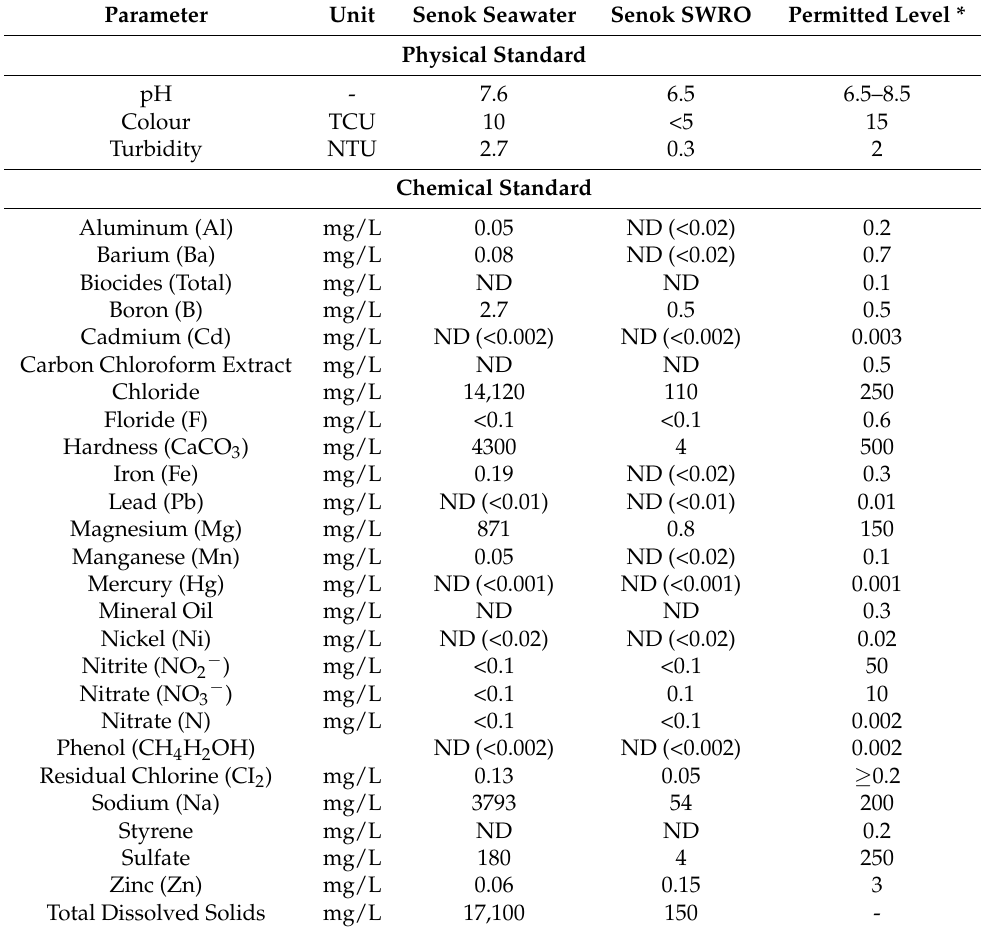
Table 4. Water quality analysis before and after treatment for Senok SWRO